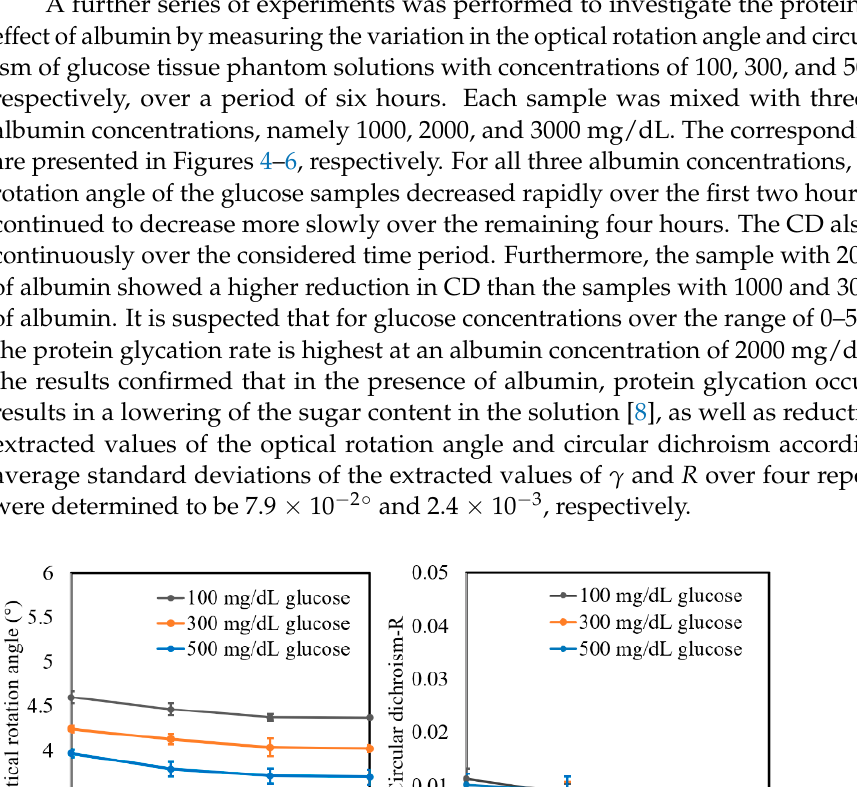
Figure 4. Experimental results for variation in: ( a ) γ and ( b ) R of glucose tissue phantom solutions mixed with 1000 mg/dL of albumin over time interval of 6 h.